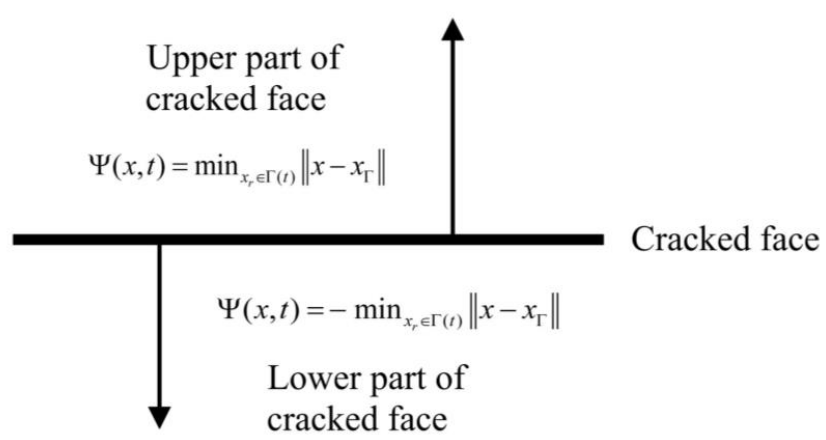
Figure 11. Crack level set.